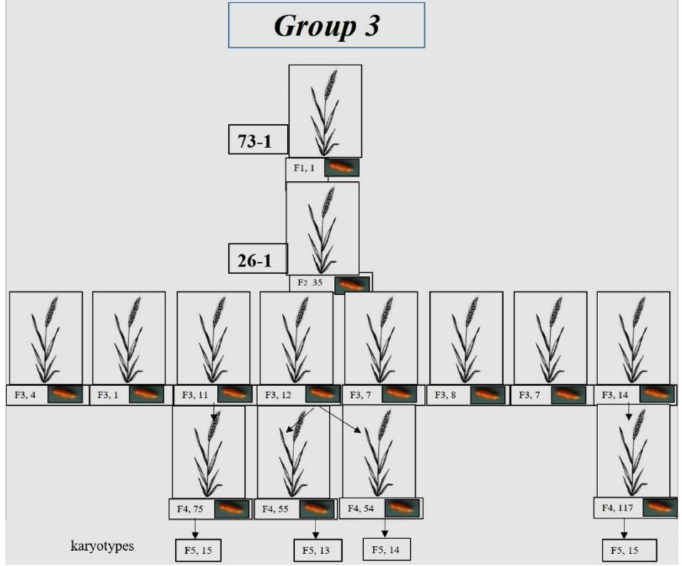
Figure 3. Development of wheat–rye hybrids of Group 3. The scheme shows individual plants of the F 1 –F 4 generations and the number of seeds in these plants. The number of plants in the F 5 generation in which the karyotype was analyzed is